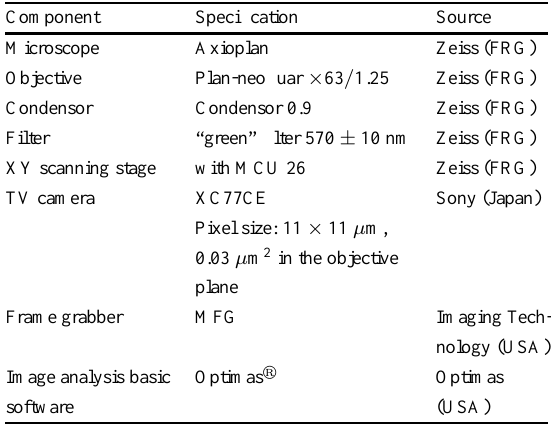
Technical equipment of the image cytometry workstation for DNA